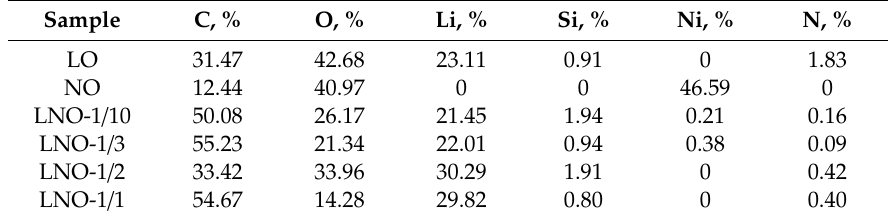
Table 2. Chemical composition of the surface of the LNO deposited on the stainless-steel support.